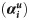
Results.(a) Model comparison: model frequencies and exceedance probabilities (XP) of the fitted models based on the AIC. Red lines: 0.25 chance level for model frequency and 0.95 threshold for exceedance probability. (b, c) Learning rates of the winning model VS. (b) Comparison between private (αp) and imitation (αi) learning rates. (c) Comparison between imitation learning rates when observing the UD (αiu) and the SD (αis). *p<0.05, ***p<0.001, Wilcoxon test. Underlying data can be found in https://github.com/hrl-team/mfree_imitation/. AIC, Akaike Information Criterion; DB, decision biasing; MB, model-based imitation; RW, Rescorla–Wagner; SD, Skilled Demonstrator; UD, Unskilled Demonstrator; VS, value shaping.